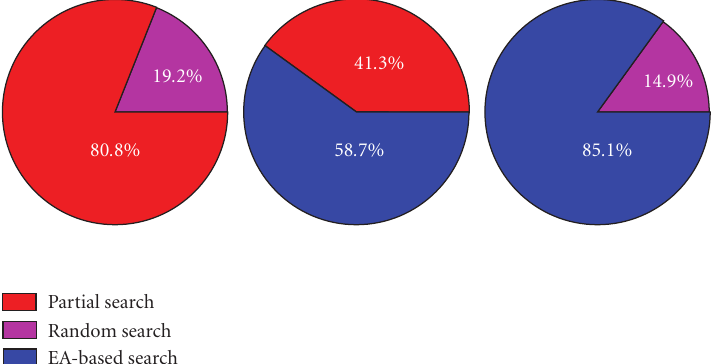
Figure 7: Comparison of search methods using the ratio of nondominated individuals (RNIs).